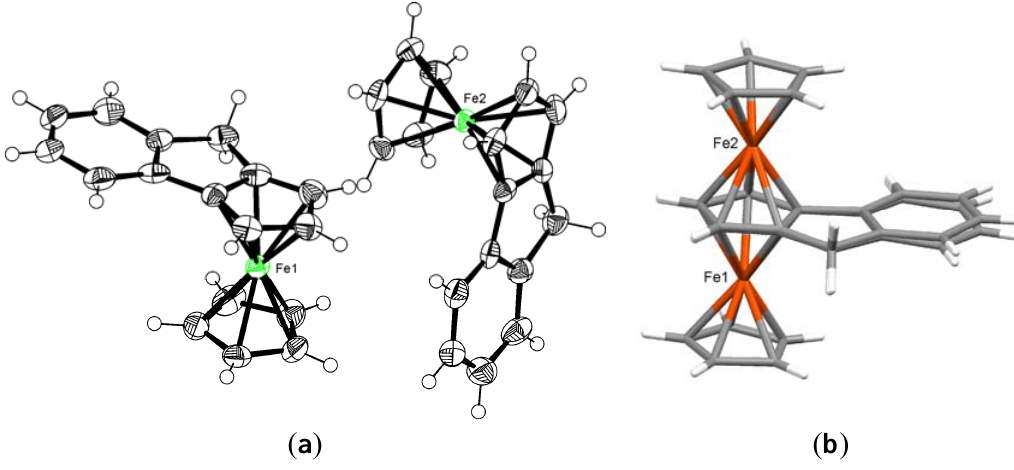
Figure 2. ( a ) Two independent molecules in the crystal structure of 3 ; ( b ) Overlay of the two enantiomers.